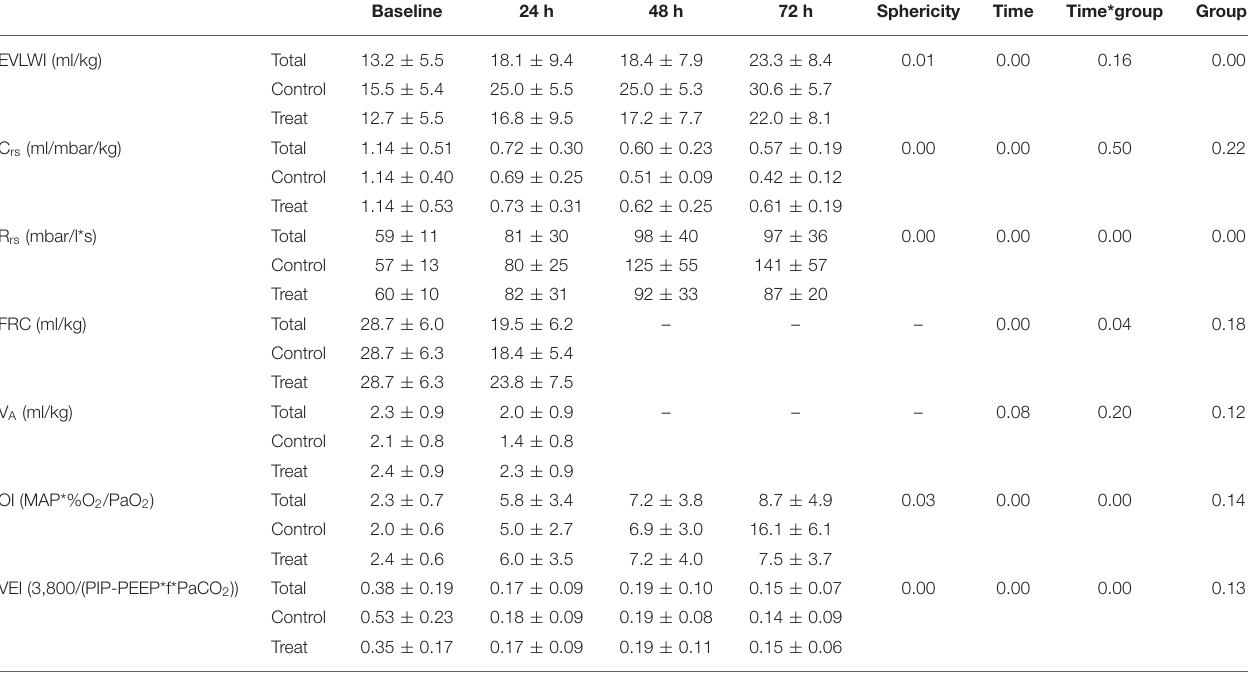
TABLE 4 | Lung function. Baseline 24 h Sphericity